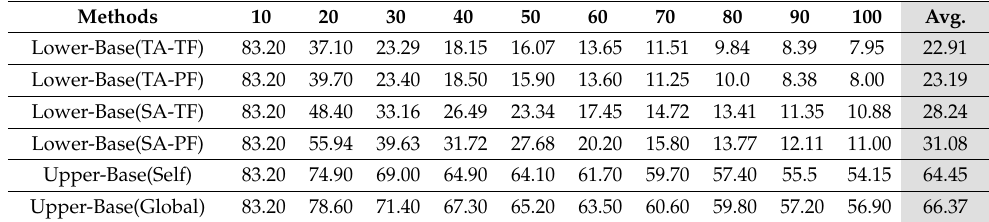
Table 3. CIFAR100: Comprehensive performance on sparse tasks.